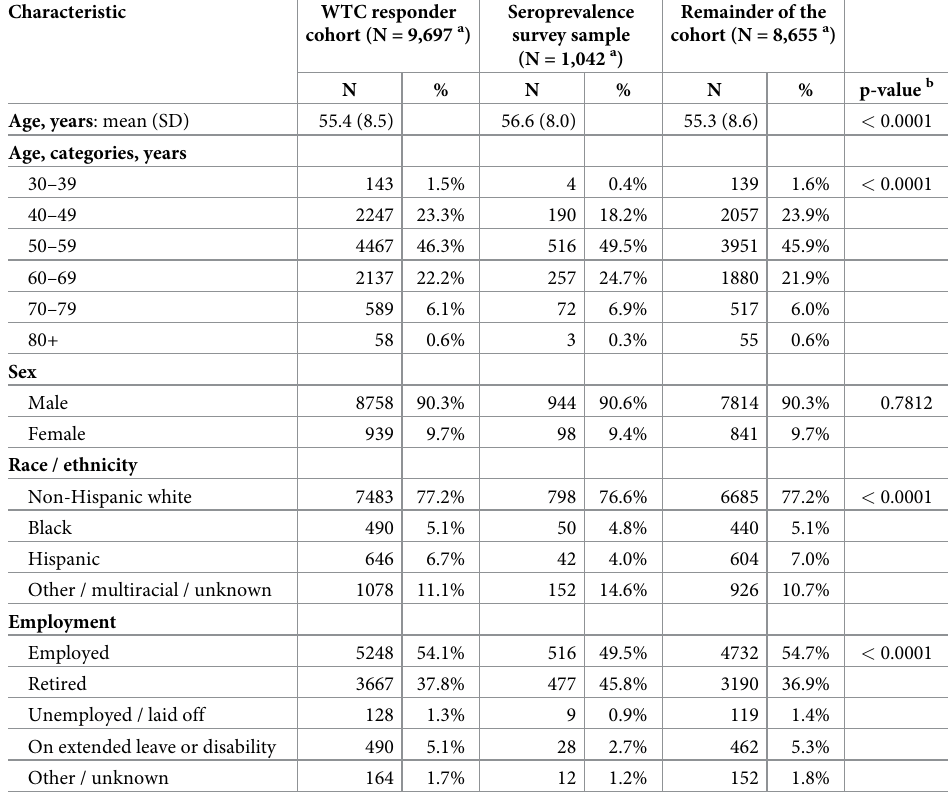
Table 1. Demographic characteristics of the World Trade Center responder cohort (N = 9,697) disaggregated by participation in the seroprevalence survey (N = 1,042 participants). Characteristic WTC responder cohort (N = 9,697 a